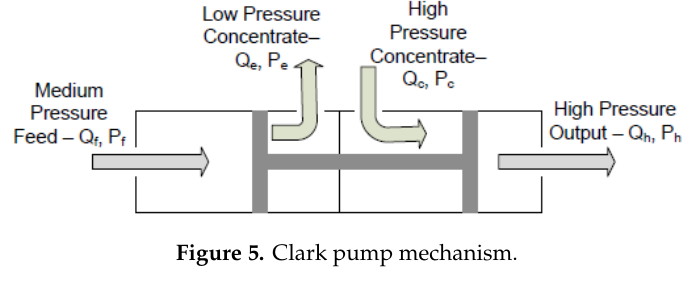
Figure 5. Clark pump mechanism.